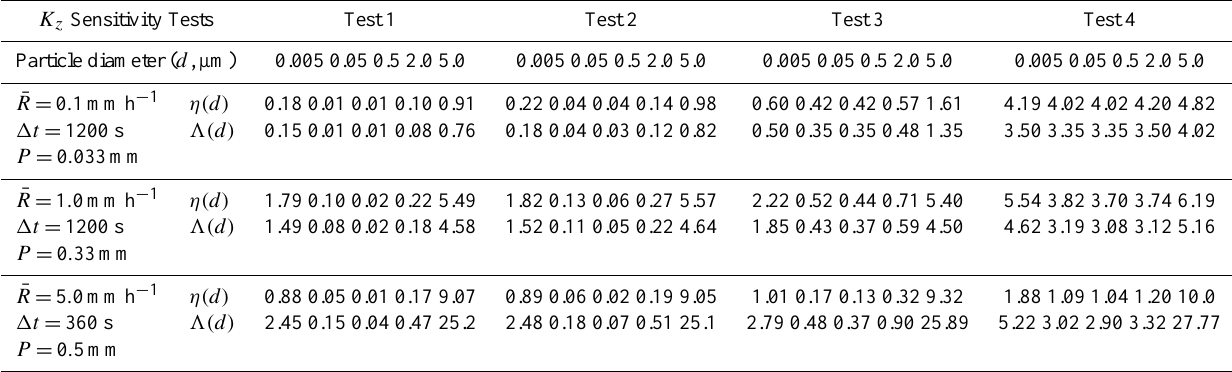
Table 1. Percentage removal ( η(d) = - 1C(d) / C(d) × 100%) and the corresponding scavenging coefficient 3 ( d) ( × 10 − 5 s − 1 ) at 16m predicted from Eq. (3) for five selected particle sizes ( d = 0 . 005, 0.05, 0.5, 2.0 and 5.0µm) from the four K z sensitivity tests ( K z = 0, 0.013, 0.15 and 1.5m 2 s − 1 at 16m) under three precipitation intensities ( ¯ R = 0 . 1, 1.0 and 5.0mmh − 1 )